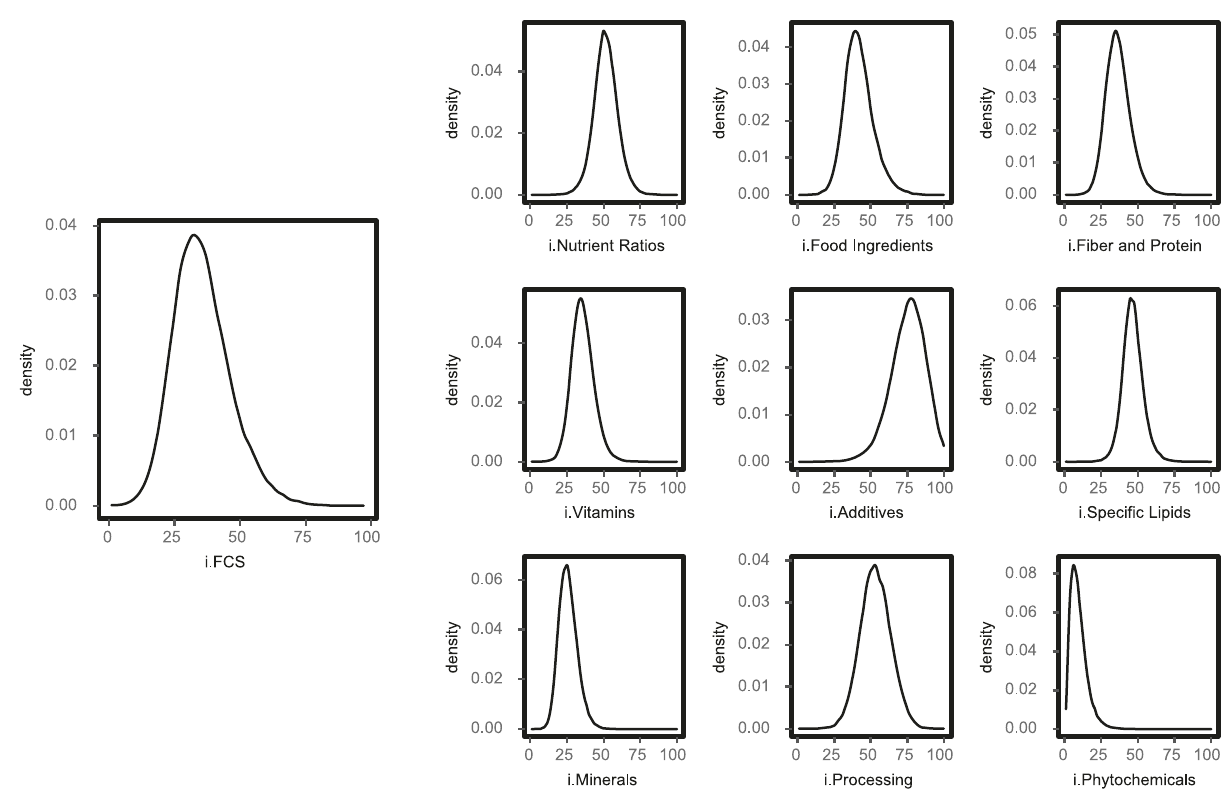
Fig. 1 | Population energy-weighted, individual Food Compass Score (i.FCS) and individual component Domain Score densities among U.S. adults, 1999 – 2018. Densityplotsre fl ectthepopulationdistributionofi.FCSamong47999 U.S.adultsfrom1999to2018.i.FCSwascalculatedastheenergy-weightedmeanof